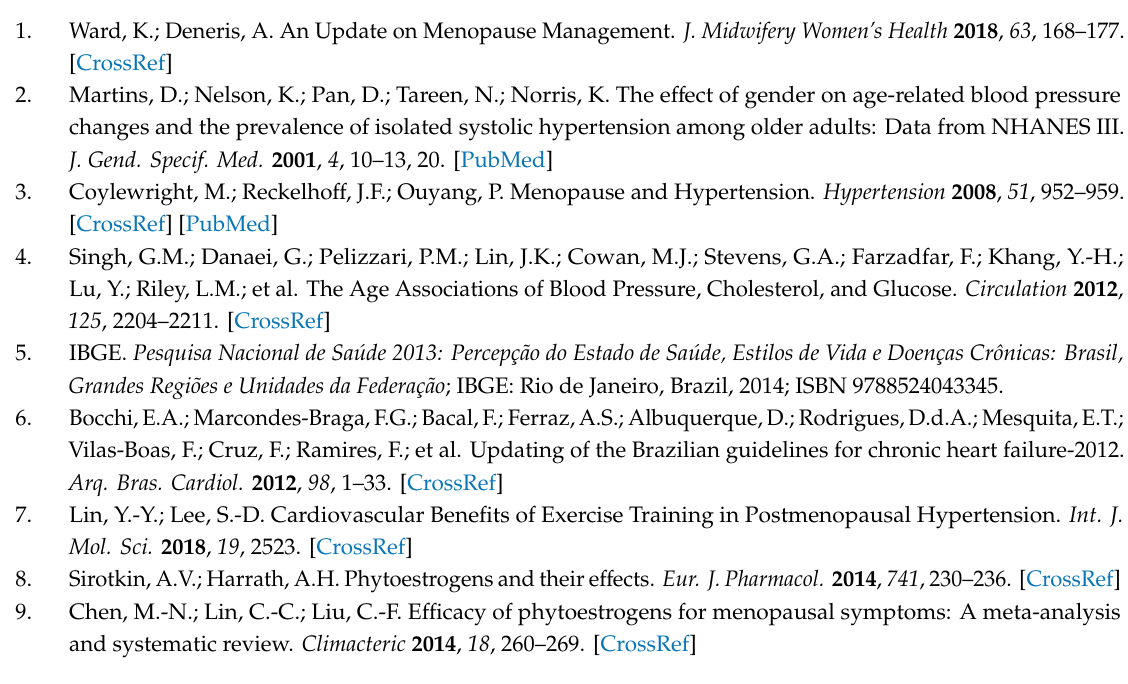
Figure S1: Per Protocol analysis of resting and AMBP results during 24 h, nigthttime and daytime periods (mean ± SD). PLA: placebo and exercise group ( n = 14); ISO: isoflavone and exercise group ( n = 17); SBP: systolic blood pressure; DBP: diastolic blood pressure; MBP: mean blood pressure; Pre: Measures pre interventions; Prost: Measures post interventions, Table S1: Per Protocol analysis of ambulatory blood pressure variability evaluated before (baseline) and after 10 weeks of exercise training in both placebo + exercise (PLA n = 14) and Isoflavone + exercise (ISO n = 17)